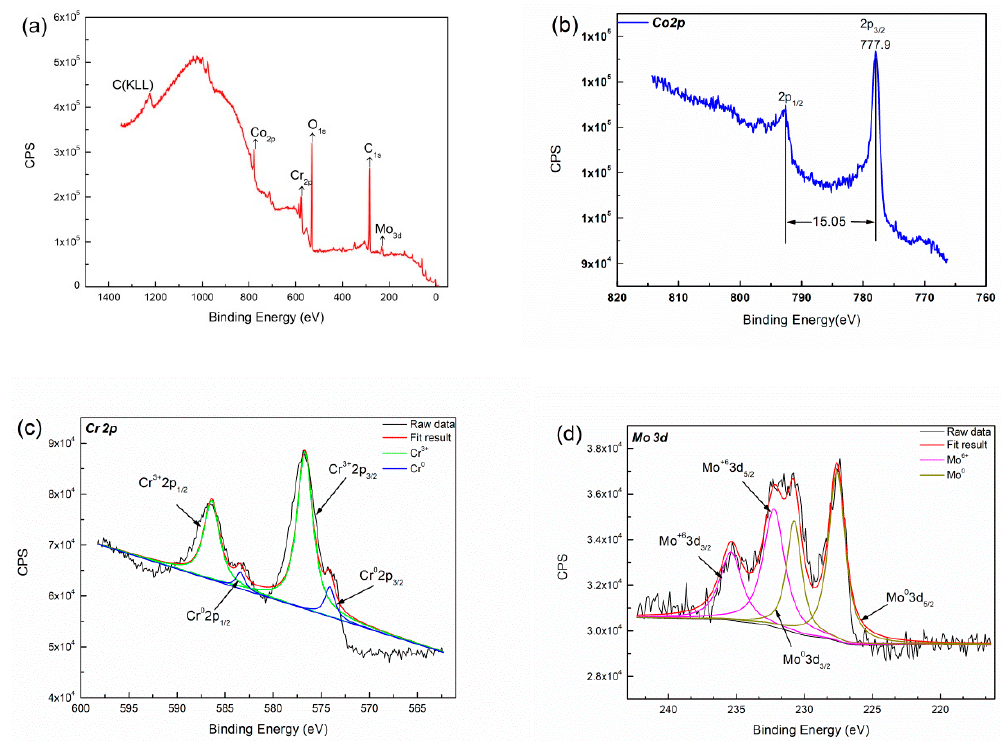
Figure 11. The survey spectra of the specimen after immersion in artificial acidic saliva for 7 days, ( a ) full spectrum scanning; ( b ) Co; ( c ) Cr; ( d ) Mo.